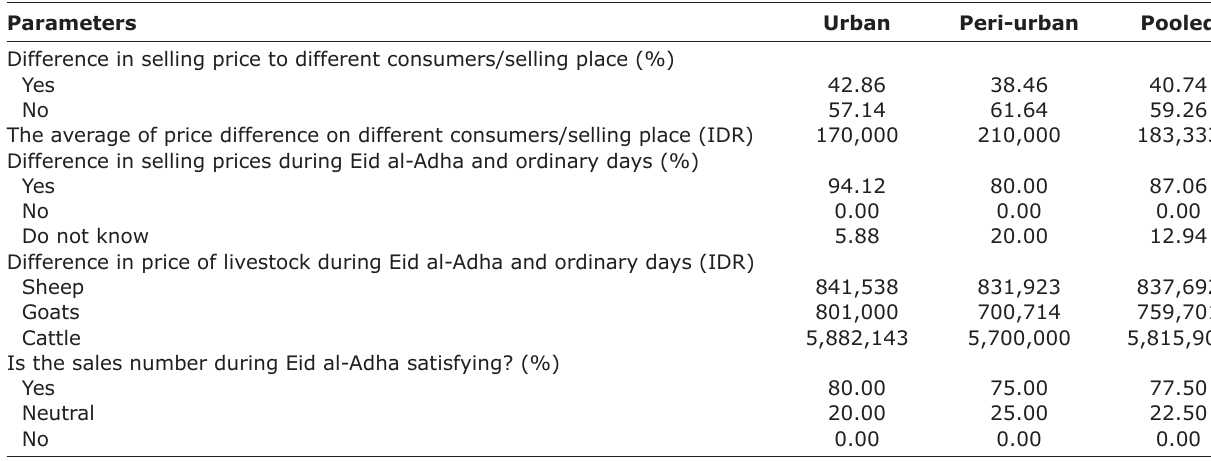
Table-4: Preference of roadside livestock traders on selling their livestock during the Eid al-Adha period. Parameters